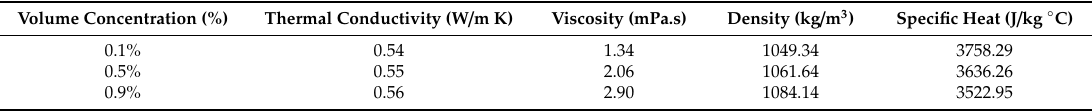
Table 3. Thermo-physical measurement of the varying volume concentration at 70 ◦